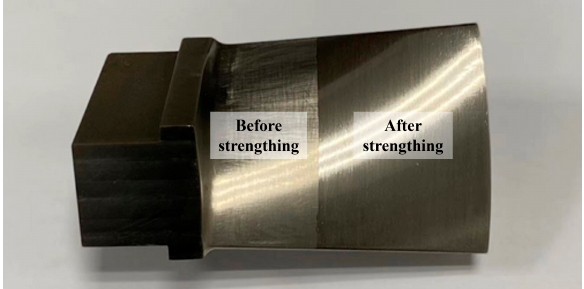
Figure 17. Aviation blade surface before and after ultrasonic surface strengthening.